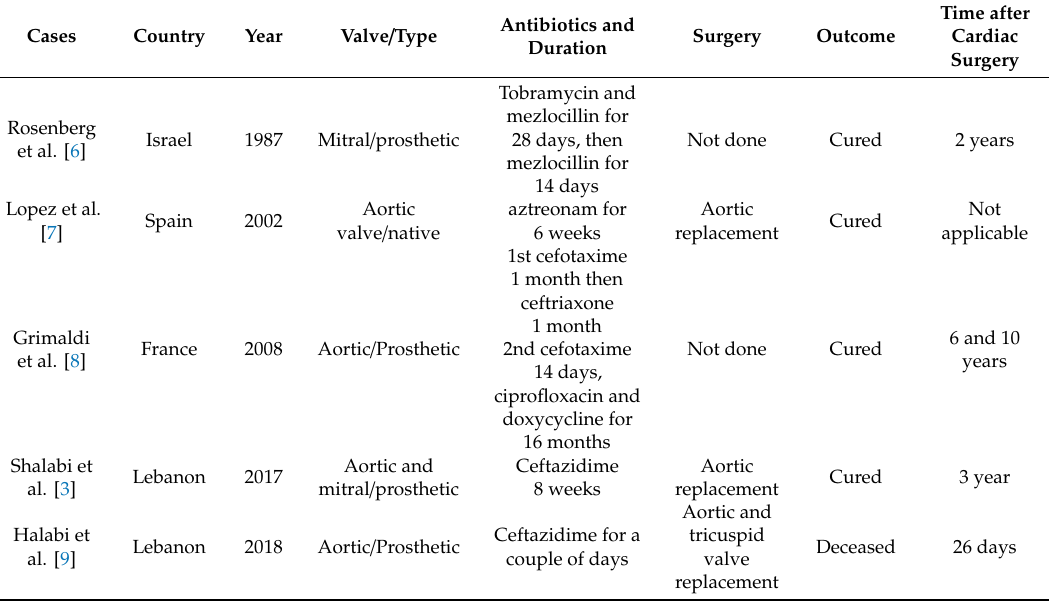
Table 1. Past case reports of infective endocarditis (IE) caused by P. stutzeri